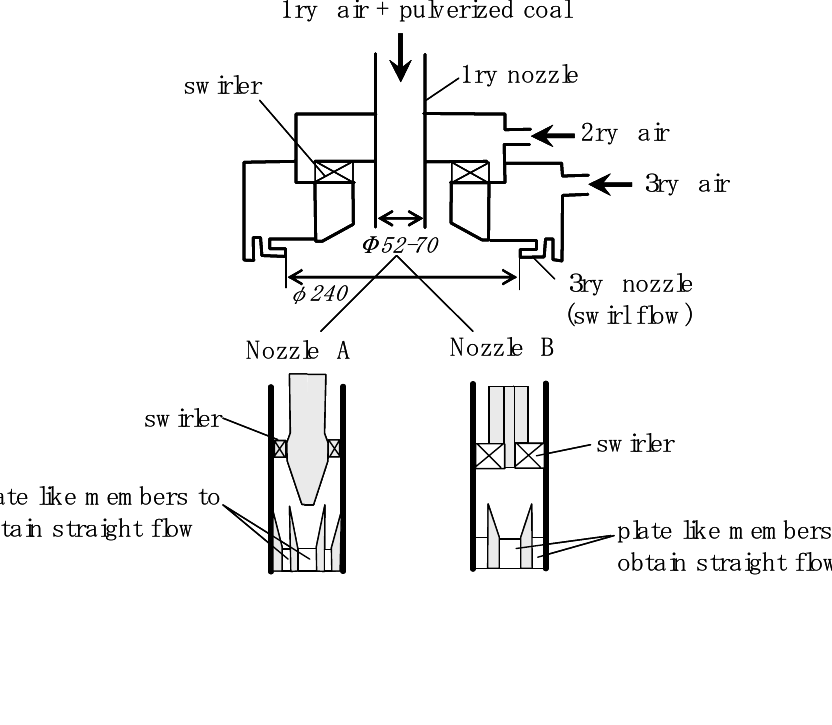
Figure 8. Structure of burner and nozzles (unit: